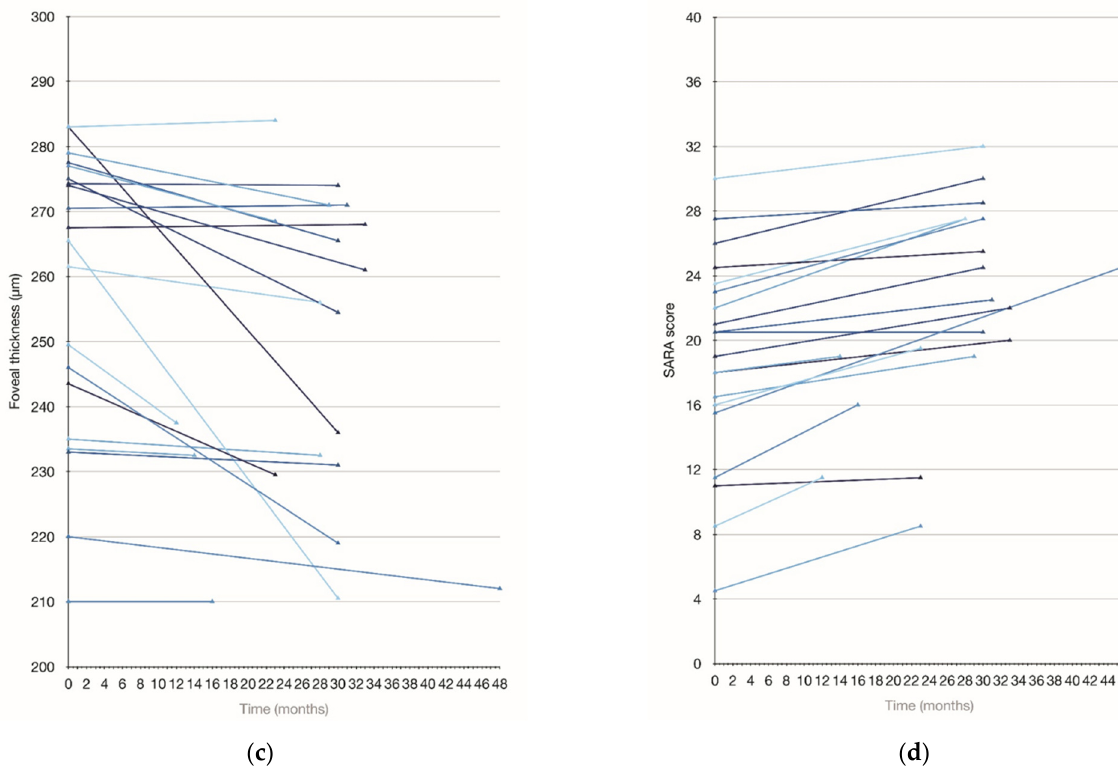
Figure 3. Retinal thickness and SARA score over time. ( a ) Average RNFL thickness at baseline and at follow-up evaluation; ( b ) Macular thickness at baseline and at follow-up evaluation; ( c ) Foveal thickness at baseline and at follow-up evaluation; ( d ) SARA score at baseline and at follow-up assessment.